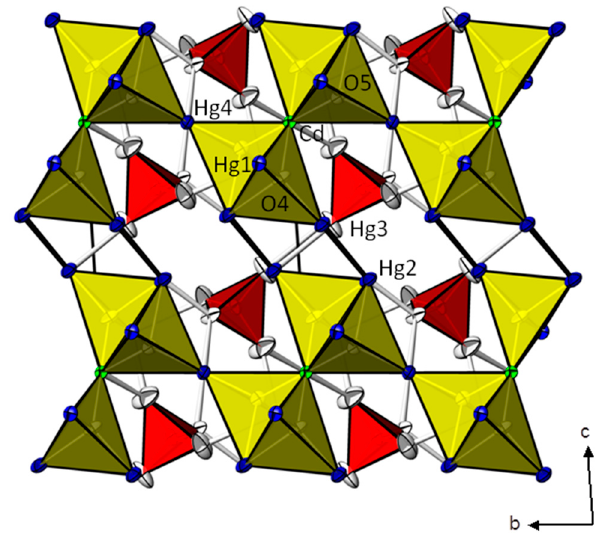
Figure 6. Crystal structure of Cd(Hg I 2 ) 2 (Hg II ) 3 O 4 (CrO 4 ) 2 using oxygen-centred [OHg 3 Cd] tetrahedra (yellow) for visualisation. Displacement ellipsoids are as in Figure 1.